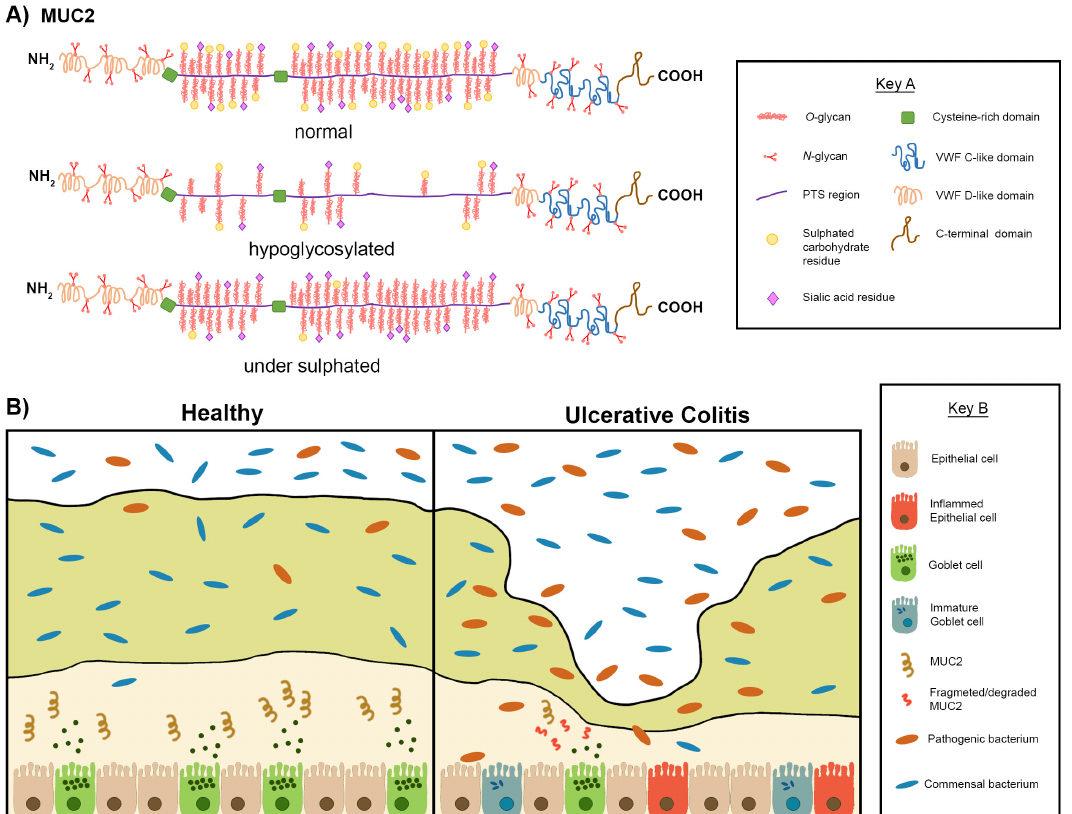
Figure 5. Graphical summary describing the various and dynamic changes in mucin structure and the mucus layer in relation to Ulcerative Colitis (UC). ( A ) Schematic representations of the mucin MUC2 with domain features explained in Key A. In UC aberrant post translational modifications can lead to hypoglycosylation of MUC2. Hypoglycosylation